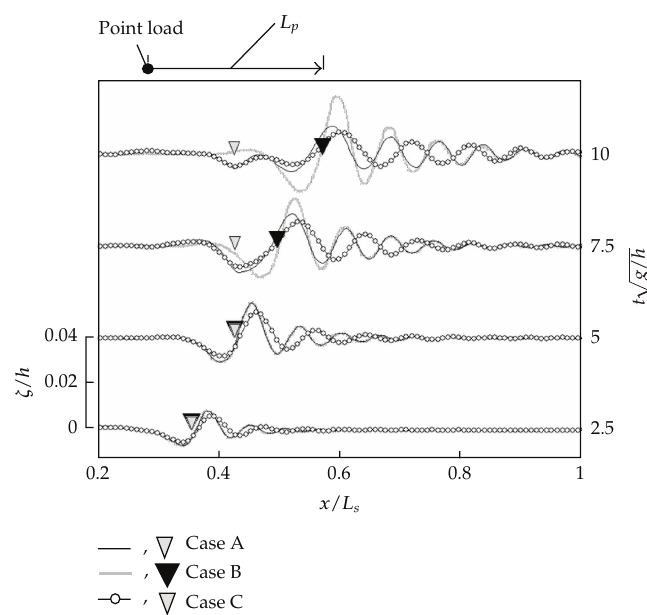
Figure 11: Time variation of surface profiles due to the point load moving on the floating thin plate, where ζ is surface displacement; k (cid:7) 1.0; N (cid:7) 2. The flexural rigidity of floating thin plate, B s , and the moving distance of point load, L p , are 500.0Nm 2 and 5.0m in Case A, 500.0Nm 2 and 10.0m in Case B, and 1000.0Nm 2 and 5.0m in Case C, respectively. The triangle marks indicate the positions of moving point loads at each time.